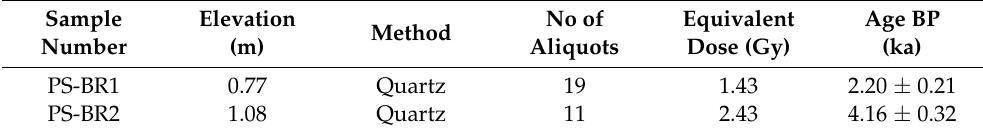
Table 2. Luminescence dating results of the selected beachrock